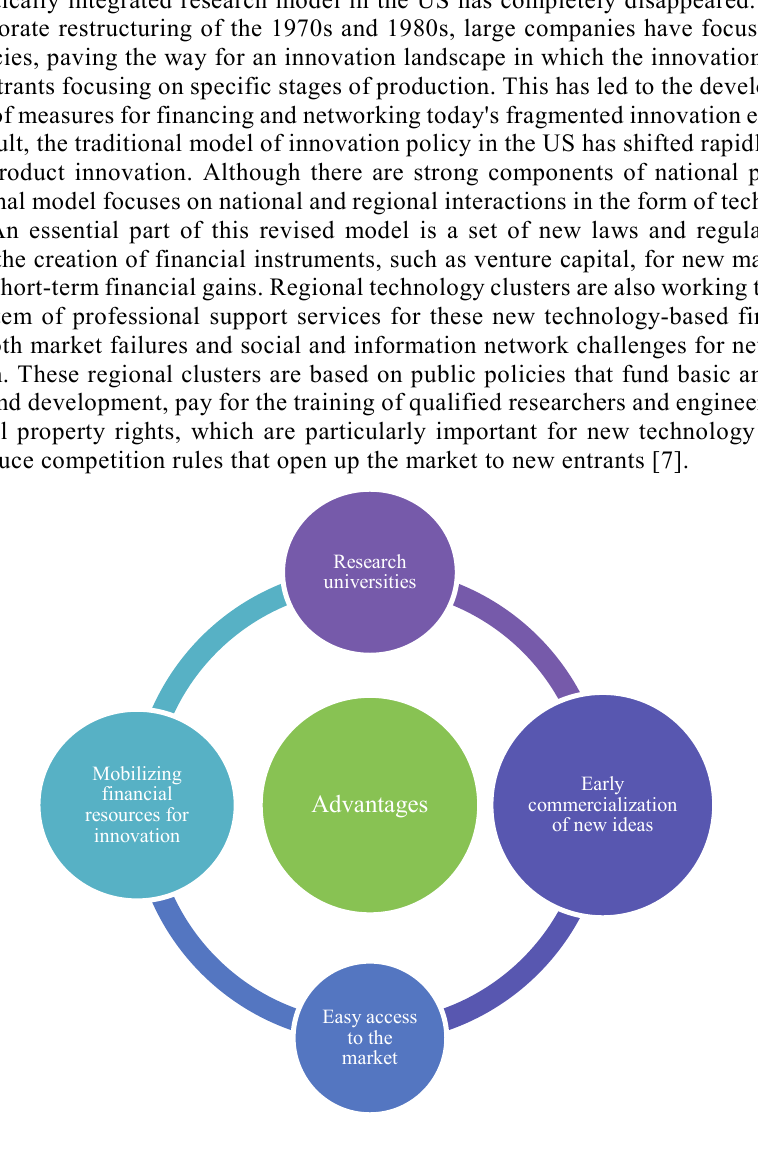
Fig. 2. Advantages of the US commercialization